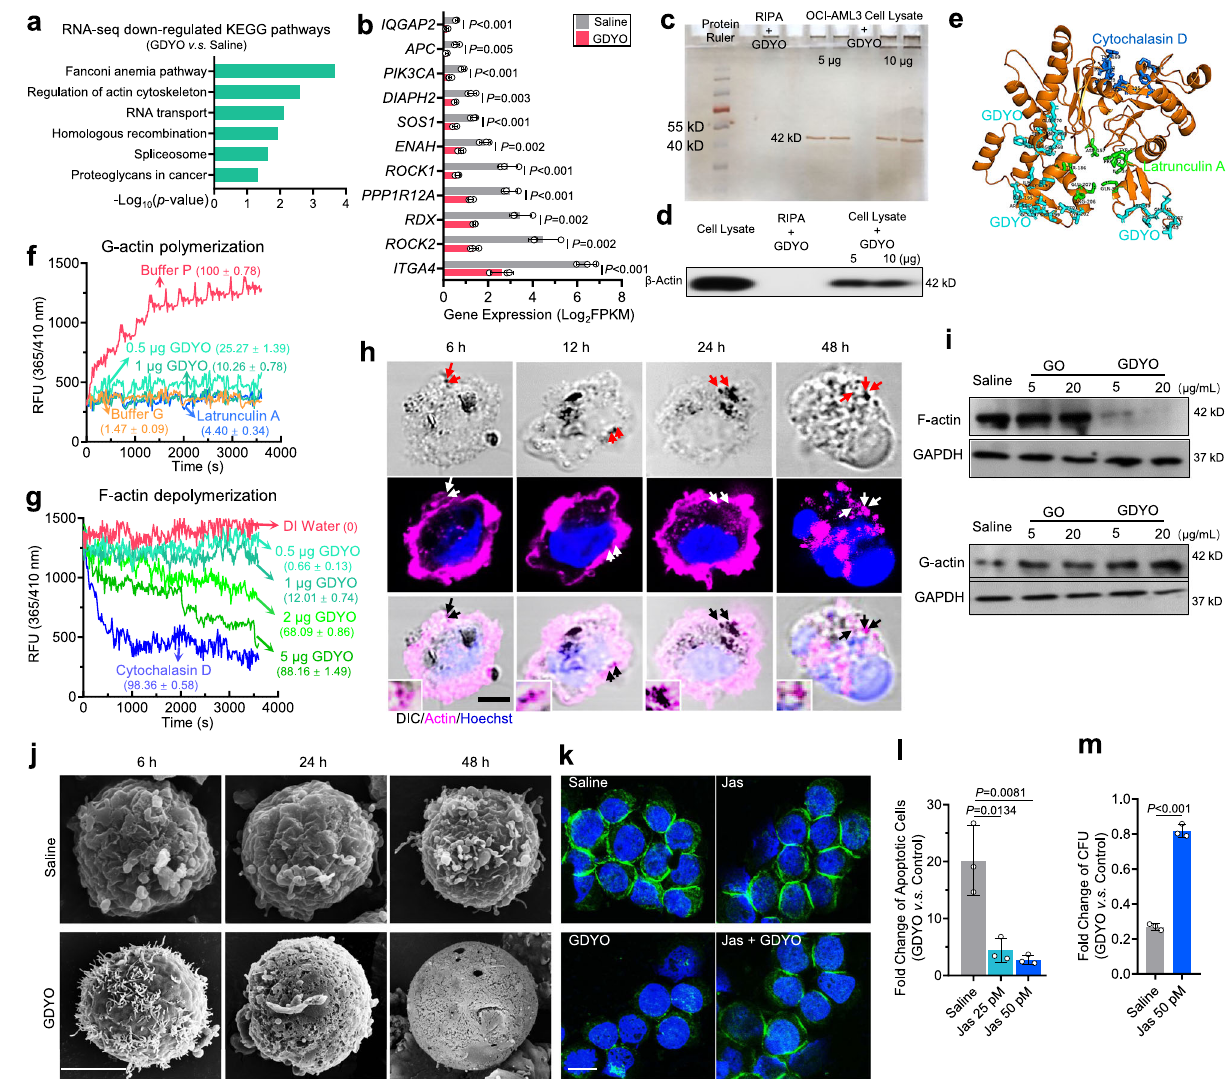
h Live cell imaging of actin with DIC component in GDYO-treated OCI-AML3 cells. Arrows indicated the co-localizations of GDYO nanosheets and actin. Scale bar, 5 μ m. i Western blot analysis of F-actin and G-actin after GO or GDYO treatment. j Representative SEM images of OCI-AML3 treated by GO or GDYO for 6, 24 and 48h. Scale bar, 5 μ m. k Representative F-actin immuno fl uorescence confocal images of OCI-AML3treated bysaline,Jas, GDYO,Jasand GDYOfor48h. Scale bar, 10 μ m. l-m Fold change of apoptosis (l) and CFU (m) for GDYO v.s . control is rescuedbyJas. n =3biologicallyindependentexperiments.Thedatawereshownas the mean±SD. Statistical signi fi cance was tested with a two-tailed, unpaired Stu- dent ’ s t test. Source data are provided as a Source Data fi